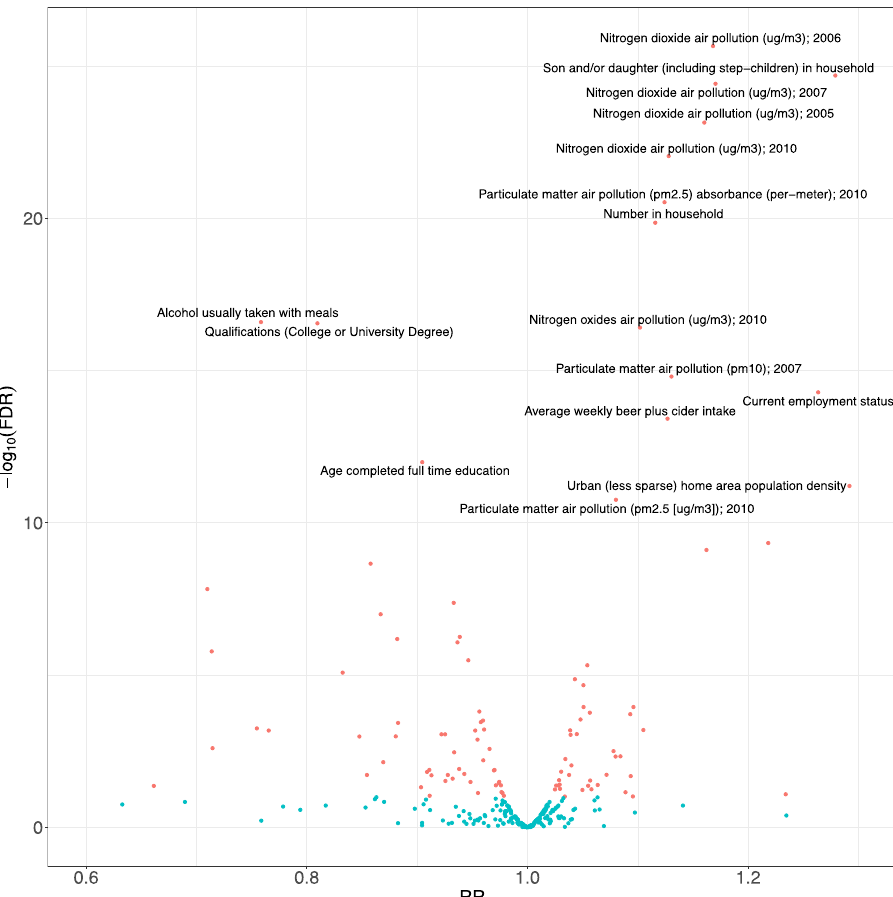
Fig. 3 Association size versus -log10(adjusted p -values) for COVID-19 positivity for second time point (tests between 07/18/2020 and 02/02/21). The risk ratios (RR) versus the negative log (base 10) of FDR-corrected p -values for 360 different exposures. The red color indicates FDR < 0.1 signi fi cant exposures and the blue color indicates FDR > 0.1 exposures. For the underlying dataset, n =